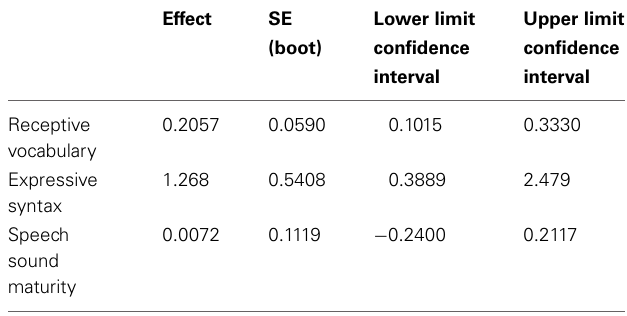
Table 6 | Indirect effect of predictor variables to